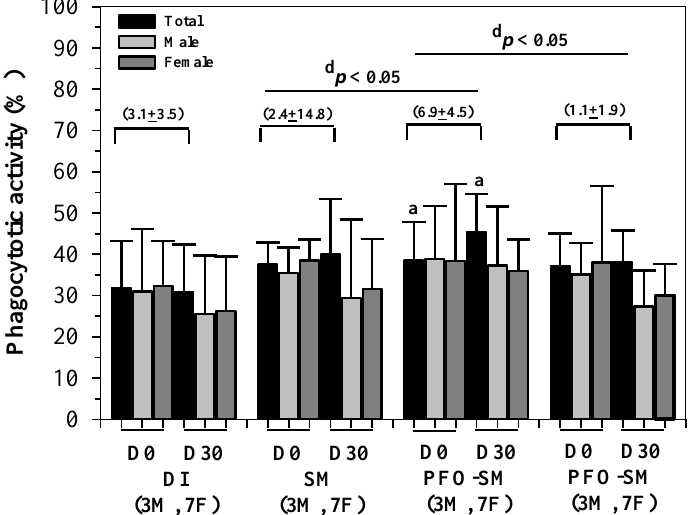
Figure 2. Phagocytotic activity of the PBMC product was determined from ten blood samples (3 male and 7 female) taken from subjects who consumed the DI, SM, PFO-SM, and BS-SM drinks for 30 days. Data are expressed as mean ± SD values. Accordingly, a p values of <0.05 were considered significant when compared with the baseline data (D0) of the same group using a parametric paired Student’s t -test; d p values of <0.05 were considered significant when comparisons were made between changes in the 4 groups (in brackets) using the non-parametric Kruskal-Wallis test.